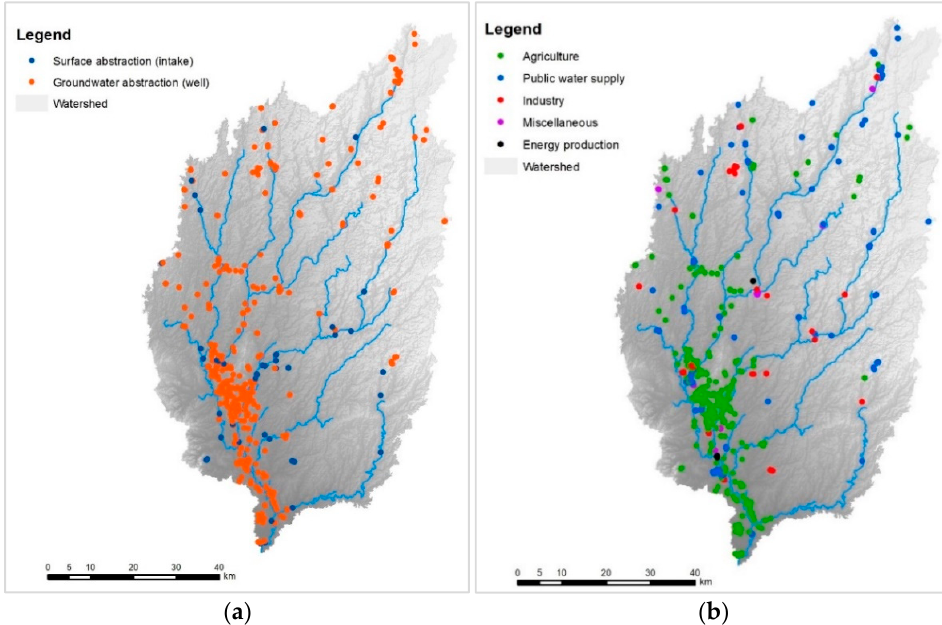
Figure 4. Water abstraction facilities (as of 2015) in the study area that significantly abstract water by source type ( a ) and by sector type ( b ).